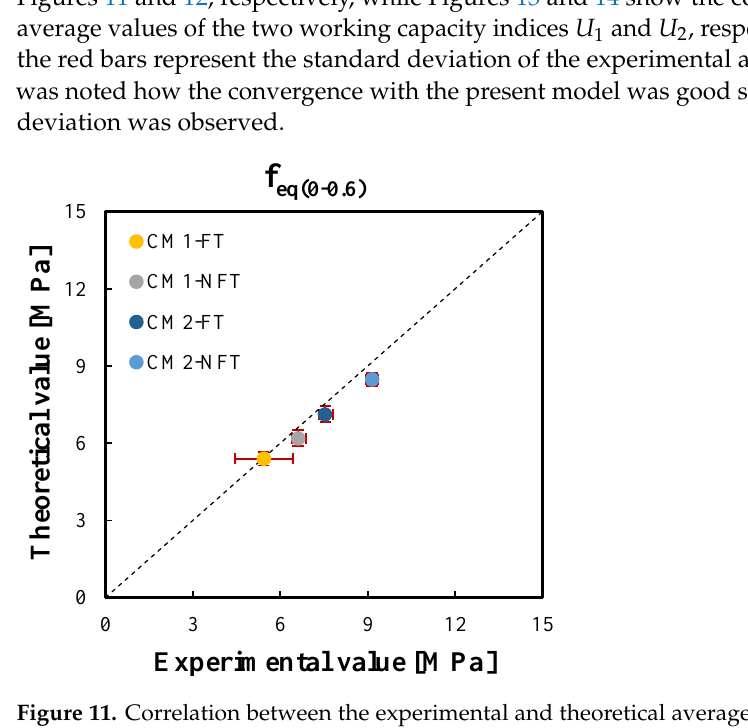
Table 6. Comparison between the experimental and theoretical average values of the two working capacity indices after the freeze – thaw cycles, 𝑈 1,𝑎𝑣𝑔𝐹𝑇 and 𝑈 2,𝑎𝑣𝑔𝐹𝑇 , and those before the freeze – thaw cycles of Ref. [42], 𝑈 1,𝑎𝑣𝑔𝑁𝐹𝑇 and 𝑈 2,𝑎𝑣𝑔𝑁𝐹𝑇 , for the CM1 and CM2 mixtures.